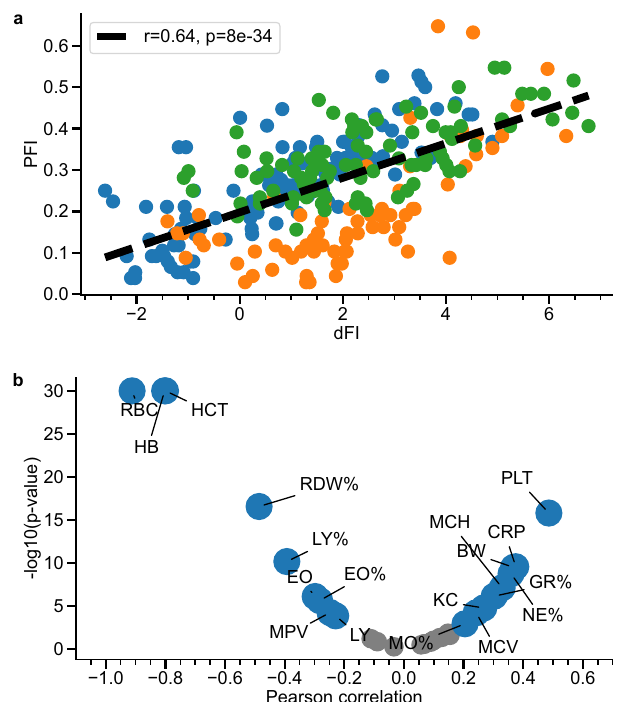
−1.0 −0.8 −0.6 −0.4 −0.2 Fig.5|CorrelationofdFIwithotherbiomarkersofaging.a Correlationbetween the dFI and the physiological frailty index (PFI). Colors represent animals from the test dataset, where blue, orangeand green circles are females in MA0071, males in MA0071 and males in MA0072, respectively. b Volcano plot representation of the dFI correlation with the extended set of biomarkers in the test datasets MA0071 and MA0072. Features with correlation above and below signi fi cance level p <0.001 are shown with grey and blue circles, respectively. The most signi fi cant correlations (excluded dFI components) were between dFI and C-reactive protein (CRP),redcelldistributionwidth(RDW),bodyweight(BW),andmurinechemokine CXCL1 (KC). Two-sided p values were calculated for the Pearson correlation coef- fi cient and the sample size of n =282